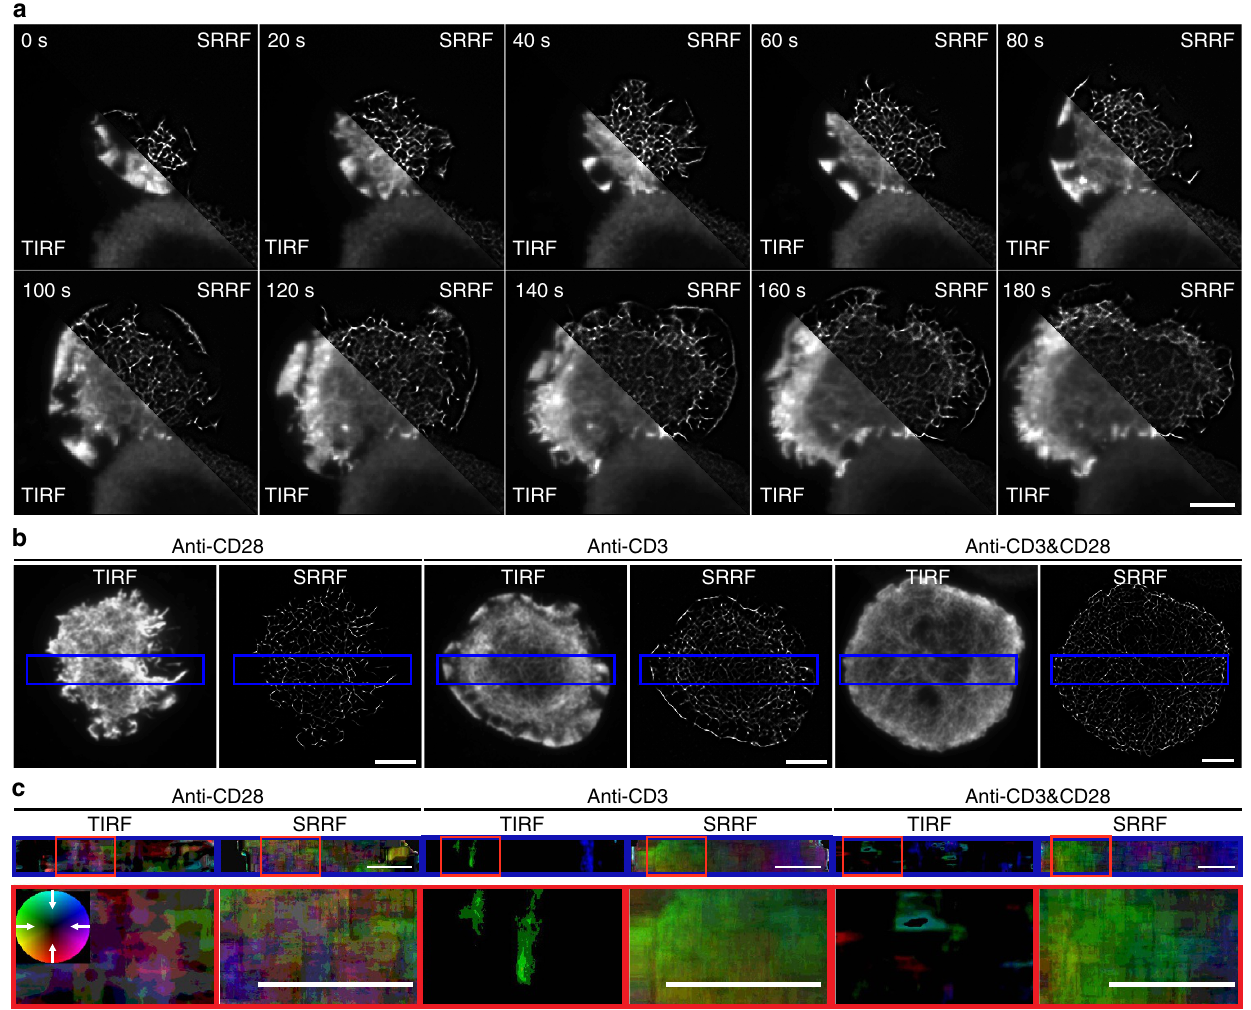
Figure 4 | SRRF used for super-resolution live-imaging of Jurkat T cells transiently expressing LifeAct-GFP. ( a ) Conventional TIRF microscopy (TIRF) versus SRRF images (SRRF) of Jurkat T cells transfected with LifeAct-GFP dropped on an anti-CD3-coated coverslip and imaged for 180s at 1 super- resolution f.p.s. ( b ) Conventional TIRF and SRRF images of Jurkat Tcells expressing LifeAct-GFP imaged on coverslips coated with anti-CD28 alone, anti- CD3 alone or in combination (anti-CD3 and -CD28) to stimulate an immunological synapse formation (highlighted area corresponds to the region used for PIV analysis). ( c ) PIV analysis of corresponding Supplementary Movies 6–8 shows notable retrograde actin flow in anti-CD3 but not in anti-CD28 stimulated Jurkat Tcells. A colour-coded measure of flow directionality and speed is plotted for the blue highlighted regions. White arrows in colour wheel are representative of flow direction, central colour (minimum intensity) corresponds to 0 m mmin (cid:2) 1 , saturated colours (maximum intensity) correspond to 38.4 m mmin (cid:2) 1 . Scale bars, 5 m